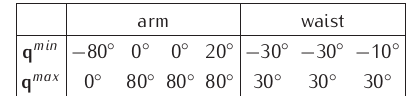
Japanese woman (see left image in Figure 3) and the overall weight is 62 kg. The degress of freedom of the robot are distributed as follows: 12 in the two legs, 3 in the waist, 14 in the two arms, 8 in the two hands, 4 in the neck and 7 in the head (see right image in Figure 3). All the joints are driven by DC motors with encoders activated by elec- tric motor drivers (Tokushu Denso Co., Ltd.); counter readings of the encoders (i.e. measure of joint angular positions) and output of the ve- locity references to the motor drivers (i.e. motor commands) are done by a PC (Pentium M 1.8 GHz, QNX Neutrino 6.3.0 operative system) embedded in the robot back through the I/O boards (HRP